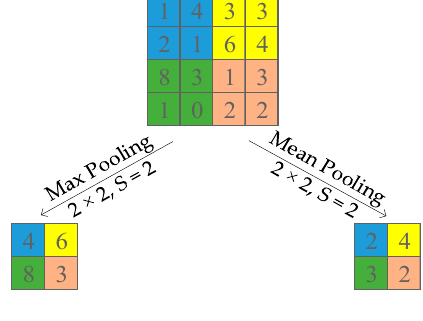
Figure 2. Pooling operation.